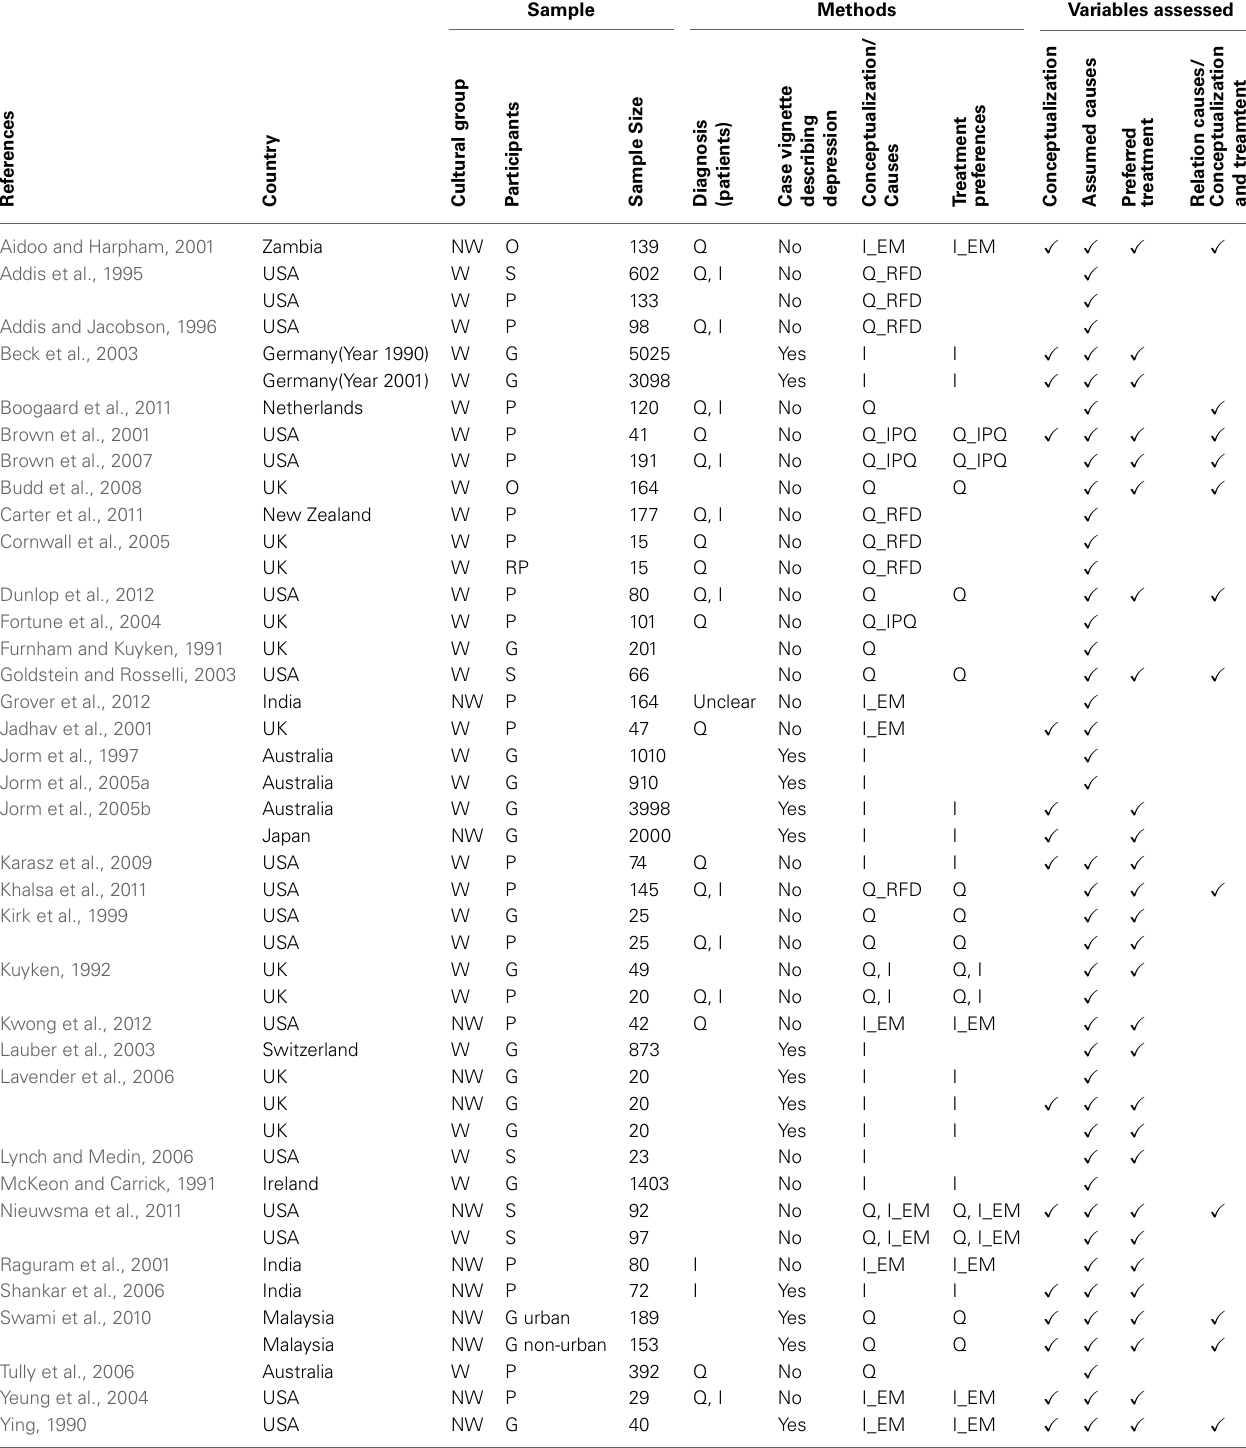
Table 3 | Overview of publications meeting inclusion criteria and description of methodological details of